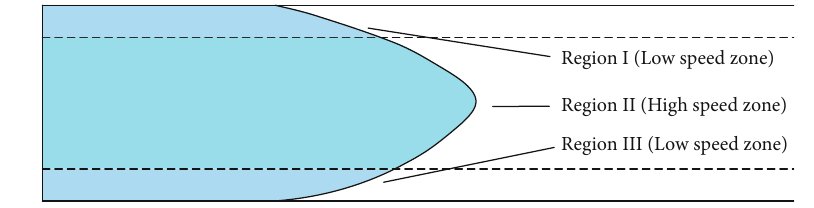
Figure 2: Fluid strati fi ed fl ow diagram.